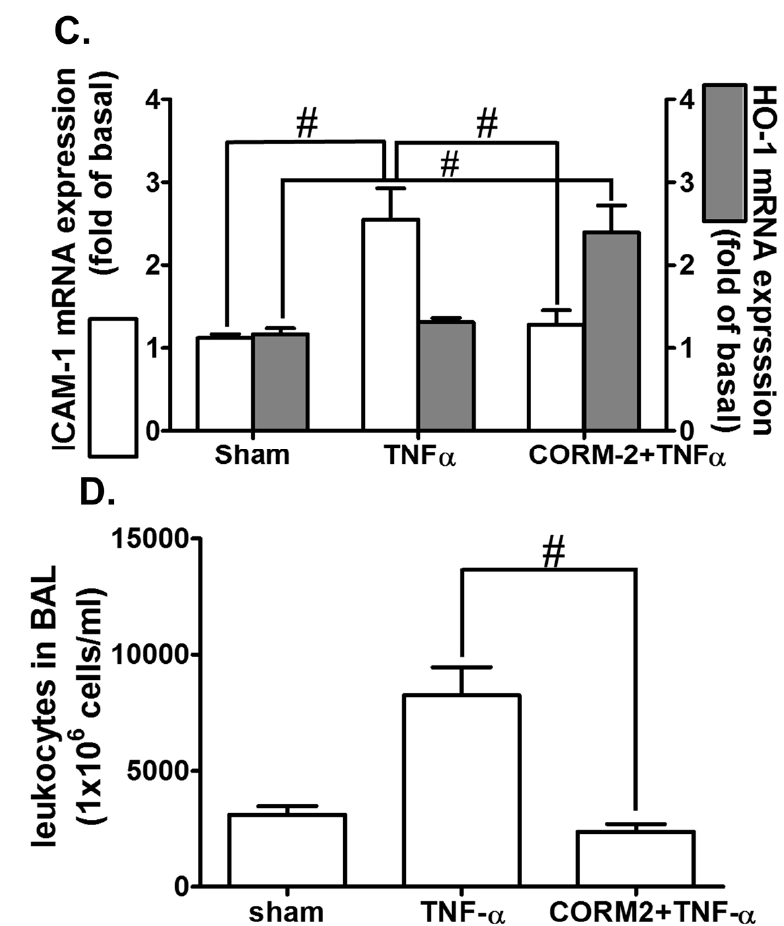
Figure 1. CORM-2 attenuated TNF- α -induced pulmonary inflammatory responses in vivo. Mice were intra-peritoneal pretreated with CORM-2 (10 mg/kg) or a vehicle for 1 h and then intra-tracheally administered with or without TNF- α (0.75 mg/kg) for 16 h. ( A ) Hematoxylin/Eosin (H/E) and immunohistochemical staining for ICAM-1 and HO-1 in serial sections of lung tissues from Sham (PBS-treated mice), TNF- α -treated mice, and CORM-2 + TNF- α -treated mice. The arrow indicates pulmonary alveolar cells displayed with ICAM-1 and HO-1 expression. ( B , C ) Lung tissues were homogenized to extract protein and mRNA. The protein and mRNA levels of ICAM-1 and HO-1 were determined by western blot and mRNA. ( D ) BAL fluid was acquired, and leukocyte count was determined by a hemocytometer. Data are expressed as mean ± SEM, n = 5. # p < 0.01, as compared between the indicated groups.